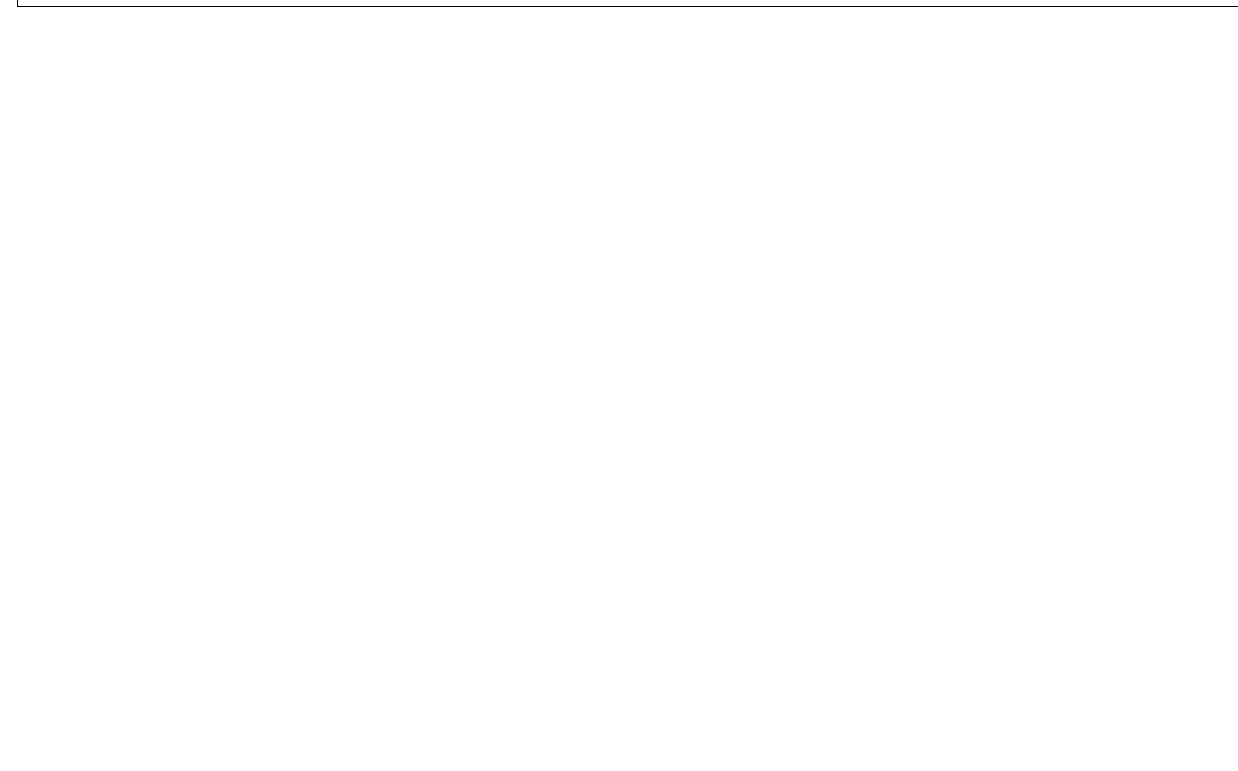
FIGUREA4 | Comparison of the putative amino acid sequences of MeIRT1 and other plant IRT1 proteins. Identical and conservative amino acids are shaded in black and gray, respectively. Dashes indicate gaps. Nine transmembrane domains (TM) were identified usingTMHMM and are shown